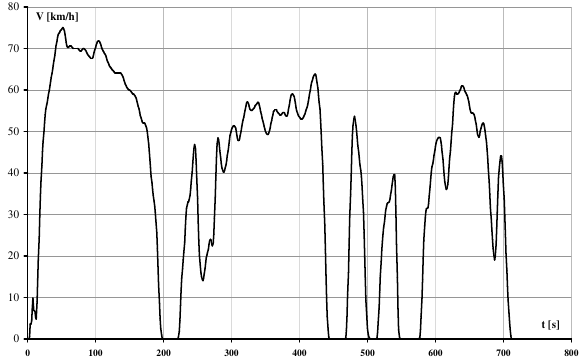
Fig. 1. The car speed variation at the greatest traffic intensity